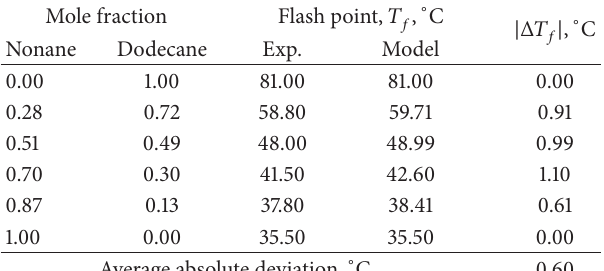
Table 7: Flash point of nonane + dodecane with different mole fractions.